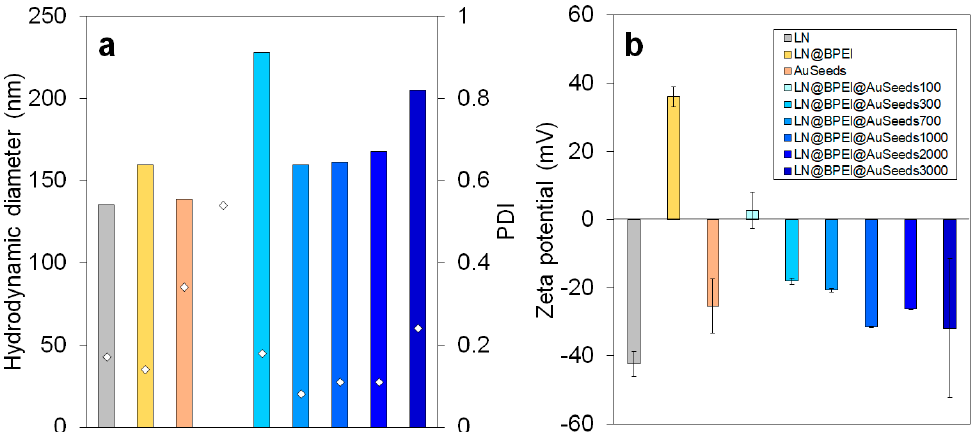
♦ symbol, shown on the corresponding hydrodynamic diameter Figure 4. ( a ) Hydrodynamic diameters and PDI ( ◊ symbol, shown on the corresponding hydrodynamic diameter bars) Figure 4. ( a ) Hydrodynamic diameters and PDI (